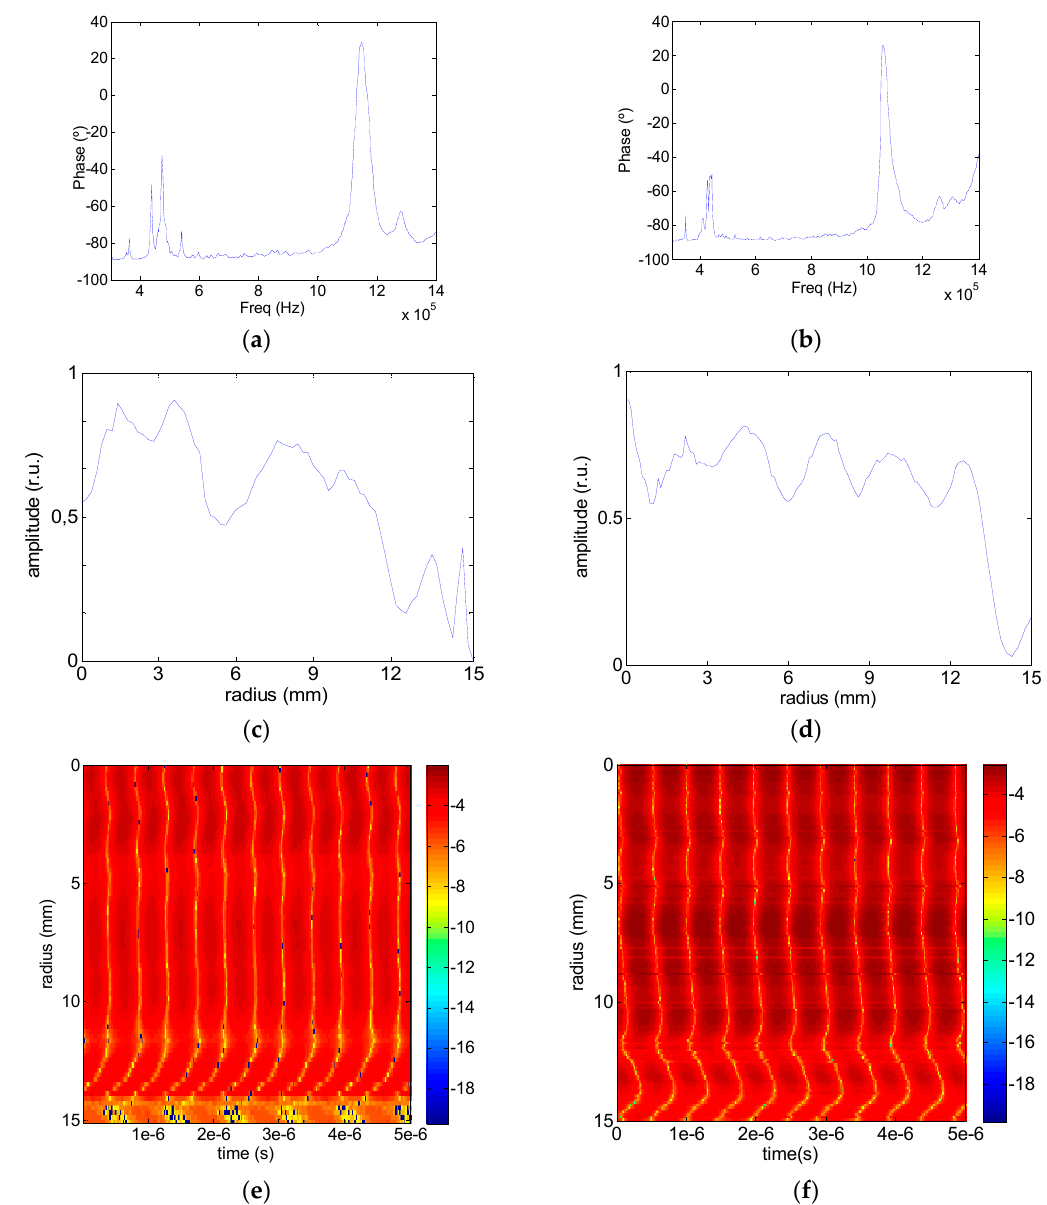
Figure 11. Experimental tests of Models 5 and 6; ( a ) Module and phase of the electrical impedance of Model 5; ( b ) Module and phase of the electrical impedance of Model 6; ( c ) Amplitude of the mechanical displacement along the radius of Model 5; ( d ) Amplitudeof the mechanical displacement along the radius of Model 6; ( e ) Relative mechanical displacement amplitude as a function of time, also along the radius (logarithmic scale) in Model 5; and ( f ) Relative mechanical displacement amplitude as a function of time, also along the radius (logarithmic scale) in Model 6.